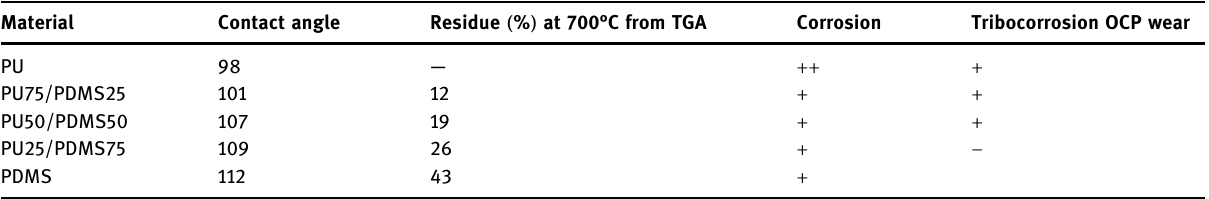
Table 5: Properties of PU/PDMS polymer blends